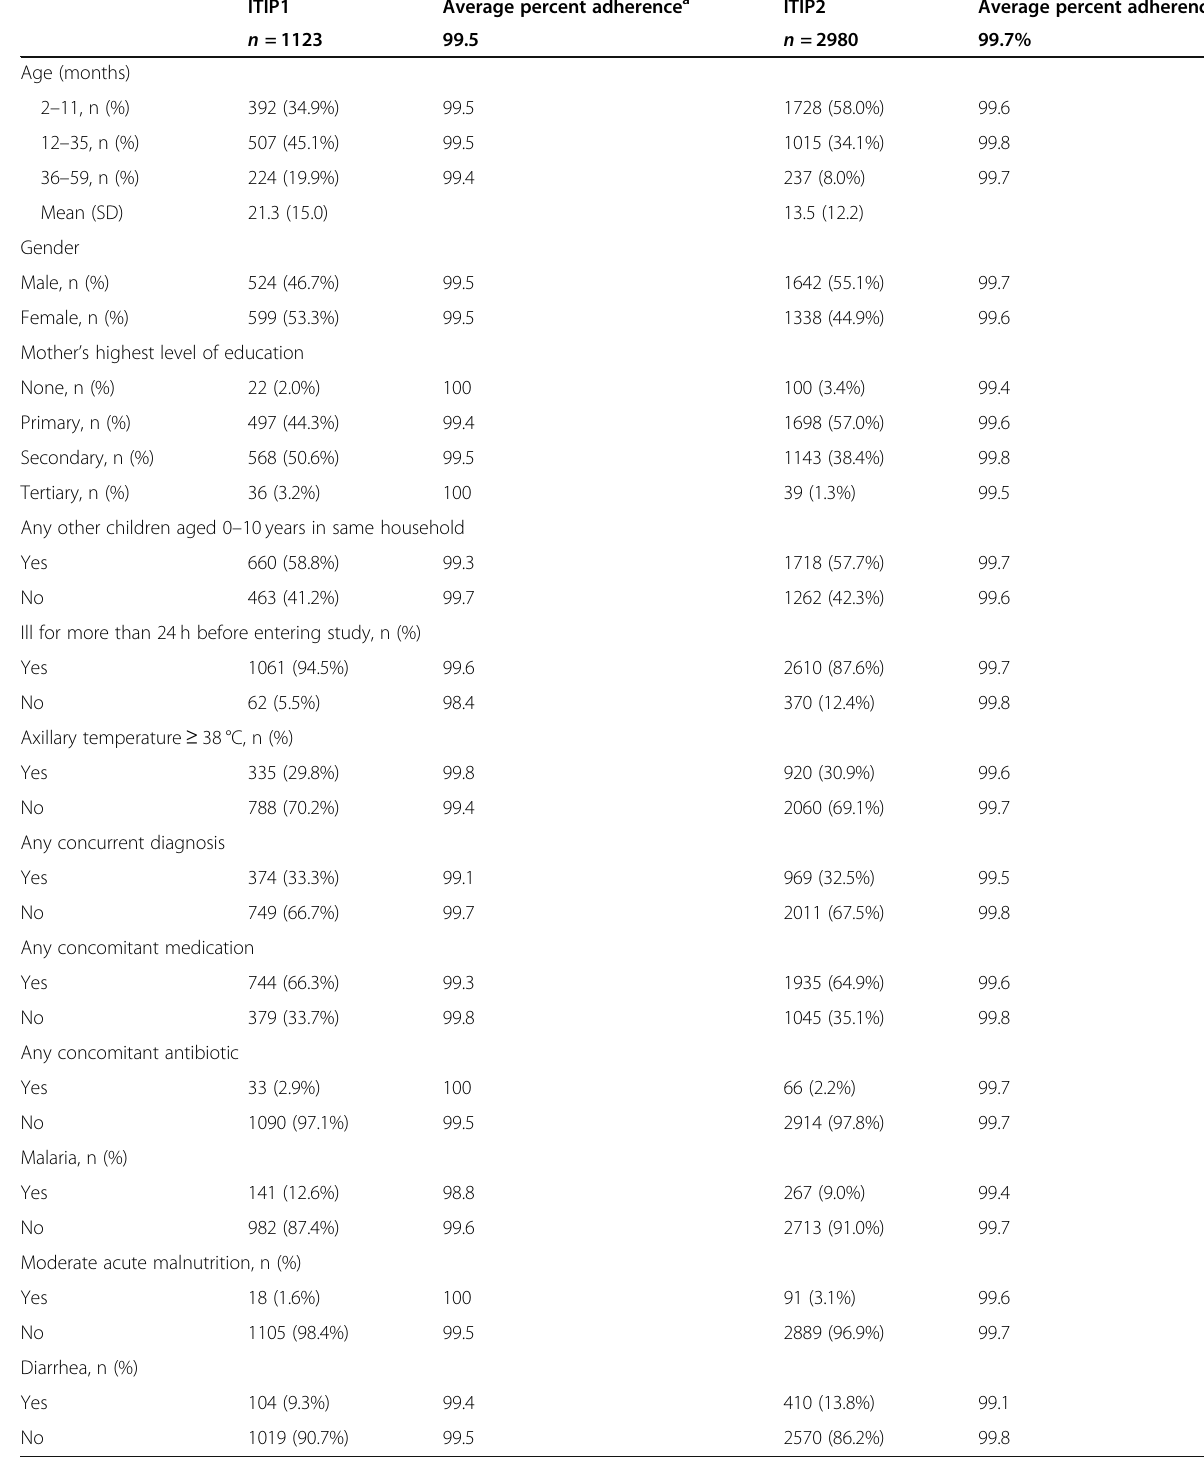
Table 1 Baseline and background characteristics and average percent adherence among enrolled children ITIP1 Average percent adherence a ITIP2 Average percent adherence a n = 1123 99.5 n = 2980